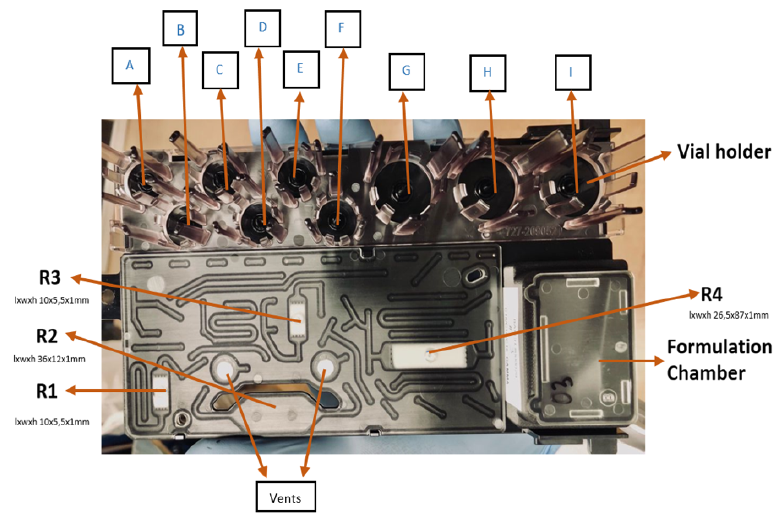
Figure 3. iMiDEV™ microfluidic cassette: Reactors (R1 – R3 for reaction and R4 for SPE purifica- tion) and vial’s positions (A to F for 4 mL vials and G to I for 15 mL